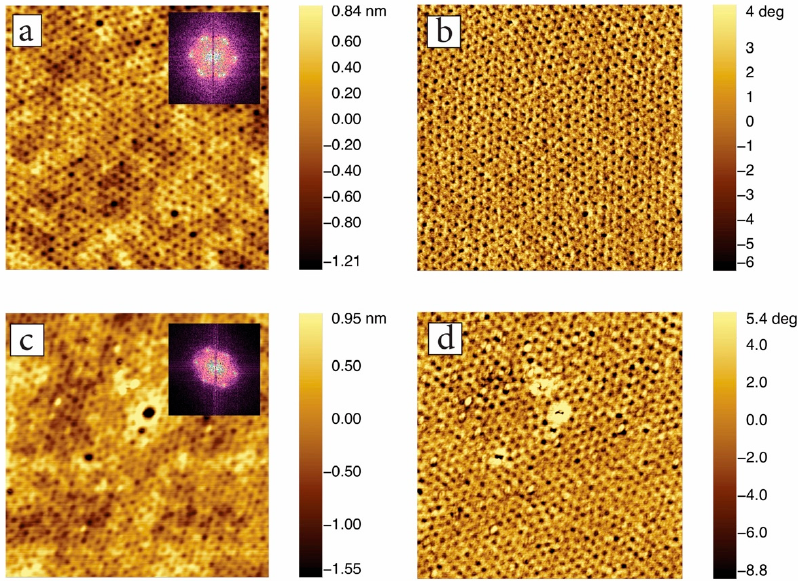
Figure 13. SFM topography ( a , c ) and phase ( b , d ) images (1 µ m × 1 µ m) before ( a , b ) and after ( c , d ) washing with ultra-pure water for 55 min. from the same sample as used for the in-situ SFM measurements. The insets in ( a , c ) show the according FFT analysis.